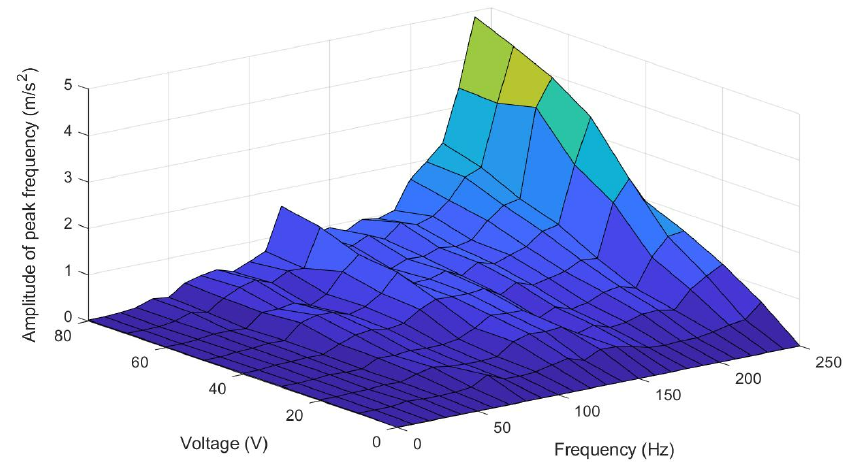
Figure 12. The acceleration amplitude of the piezoelectric ceramic at different frequency and